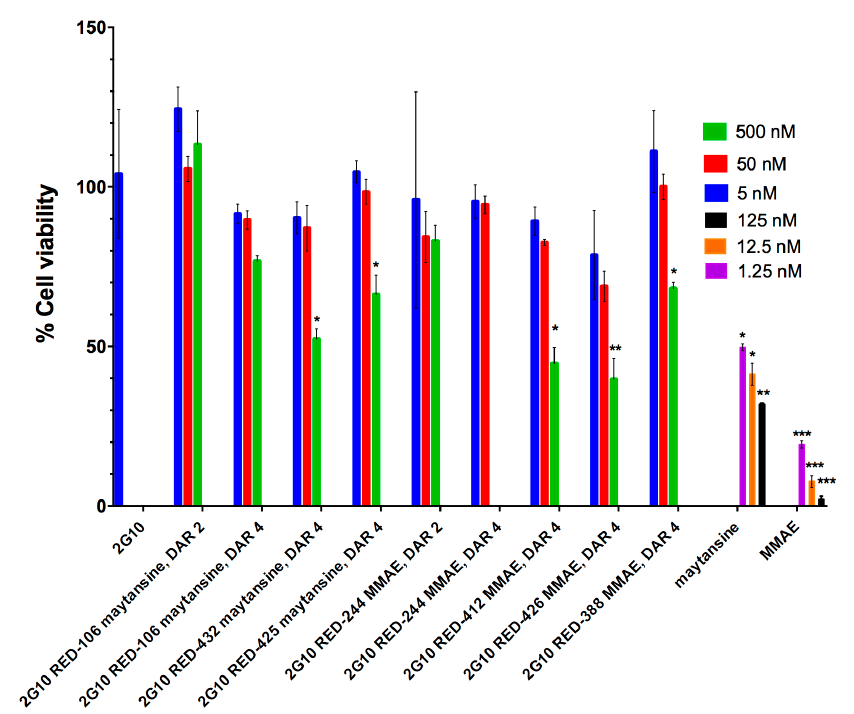
Figure 4. Effect of anti-uPAR 2G10 ADCs, IgG 2G10 alone, and free drug on cell viability. MDA-MB-231 cells (0.5 × 10 4 cells/well) were seeded in 96-well plates (Costar 3610) at the density and incubated for 120 h (5 days) with of ADCs or IgG. After 5 days of drug treatment at 37 °C with 5% CO 2 , cell viability was measured using the Promega CellTiterGlo kit following the manufacturer’s protocol. Data was collected on a SpectraMax M5 plate reader using luminescence settings. Vehicle-treated cells were set to 100% viability and the luminescence blank was set to 0%. MMAE and maytansine are shown as positive controls. All experiments were performed in triplicate, error bars indicate standard deviation. Asterisks indicate significance level compared to vehicle-treated. Multiplicity-adjusted P values from the Holm-Šidák method. * p < 0.05; ** p < 0.01; *** p < 0.001.